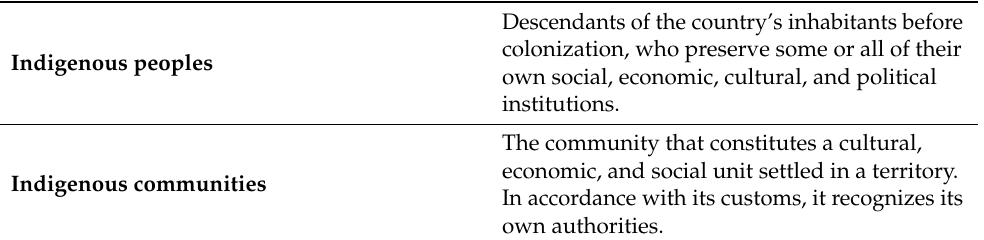
Table 1. Definition of Indigenous peoples and communities based on the Mexican Constitution. Elaborated by Gu í zar-Villalvazo, M.